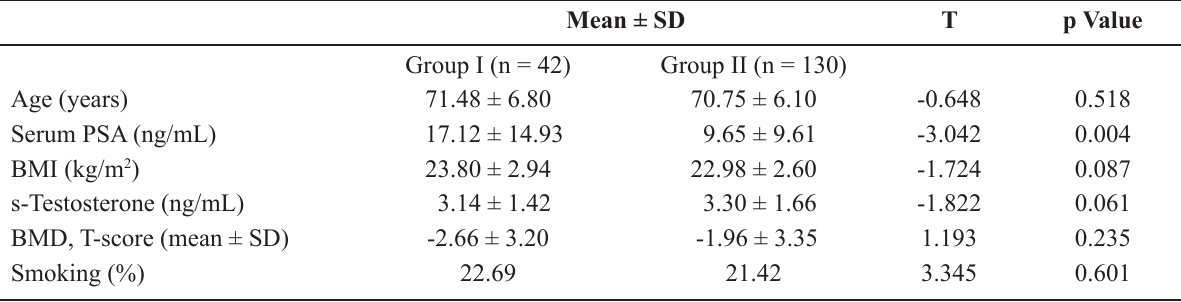
Table 1 – A comparison of the disease variables between the two groups.